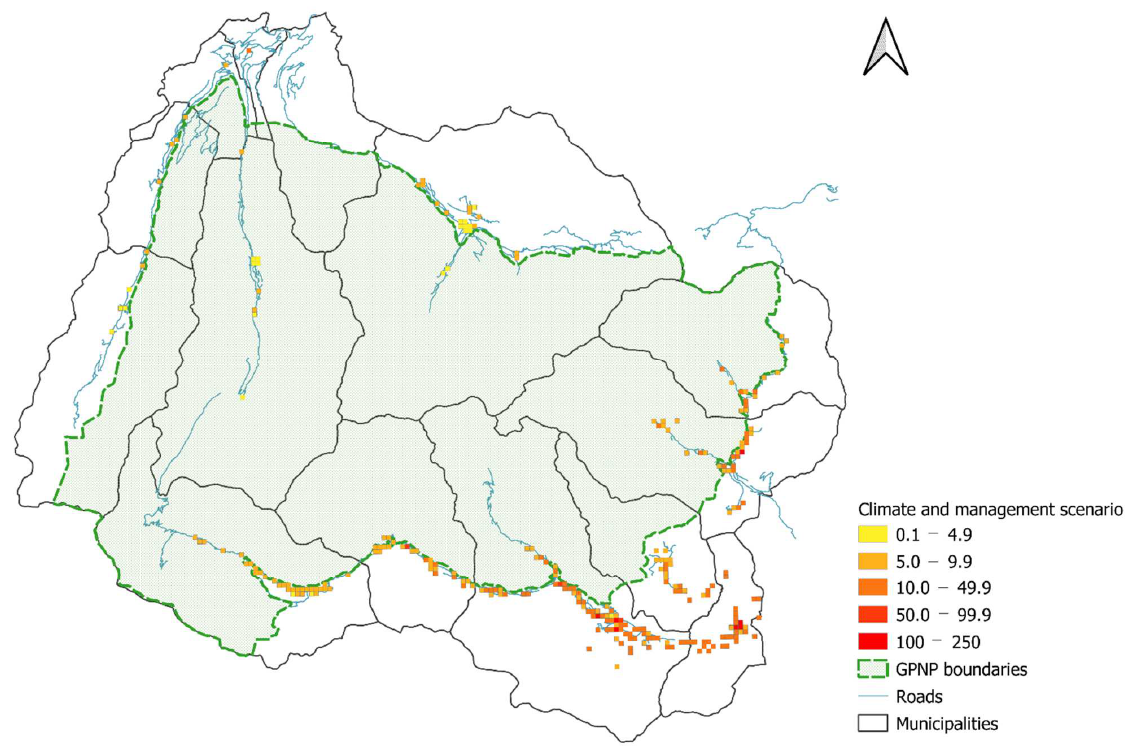
Figure 8. Expected abundance of eggs in the study area (250 m grid) in the future scenario of climate warming (increase of 1.5 °C) combined with the management strategy (50% reduction in Pelargonium plants). Table 5. Percentages of cells that showed a decrease or increase in egg abundance once the 50% Pelargonium reduction was applied.